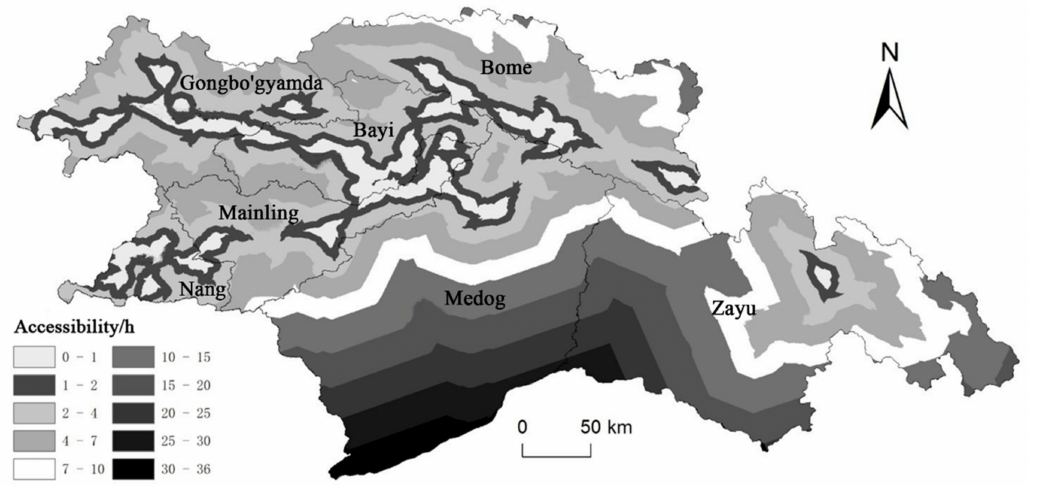
Figure 6. The current traffic accessibility with tourist attraction location as the core. Note: This map is based on the standard map of the Map Technical Review Centre of the Ministry of Natural Resources of China (Number: GS (2019)4342), with no modifications to the base map. Map-making by the